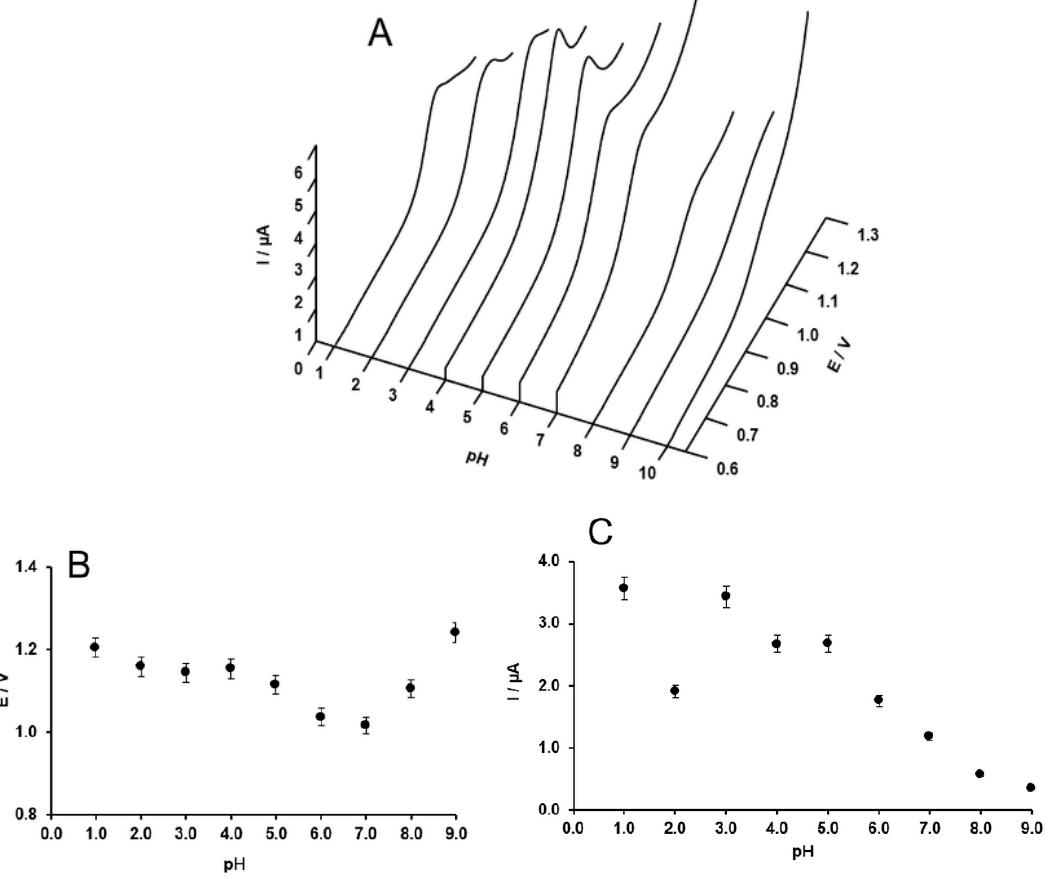
Figure 5. ( A ) Forward scan of CVs of 5 × 10 − 4 M SIM in 0.1 M H 2 SO 4 at various pH values, with a potential scan rate 50 mV · s − 1 ; ( B ) pH dependence of the peak potential; ( C ) pH dependence of the peak current.